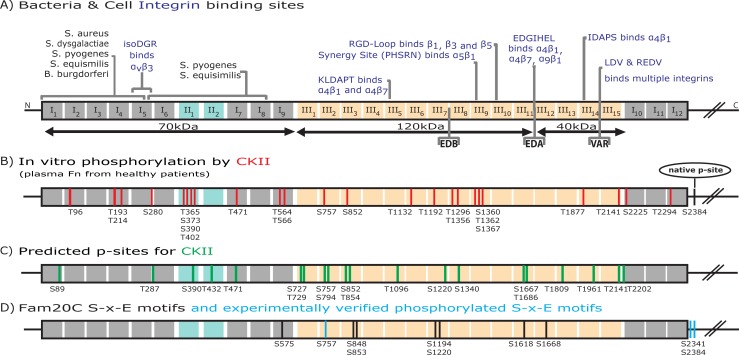
Predicted and experimentally verified phosphorylation sites on fibronectin.A: Schematic representation of plasma fibronectin isoform 1 with modules type I (gray), type II (turquoise) and type III (orange). Proteolytic fragments and cell binding sites are indicated. (See Section A in S1 File). The proteolytic fragments are derived from plasma fibronectin and thus do not contain the alternatively spliced domains- B: Fibronectin phosphorylation sites as identified by mass spectrometry (MS) after phosphorylating human plasma fibronectin in solution by CKII (red). C: Phosphorylation sites as predicted for CKII using the server NetPhosK. D: Analysis of the positions of S-x-E motifs as potential recognition sites for the Fam20C kinase and experimentally verified phosphorylated residues located in a S-x-E motif (blue).